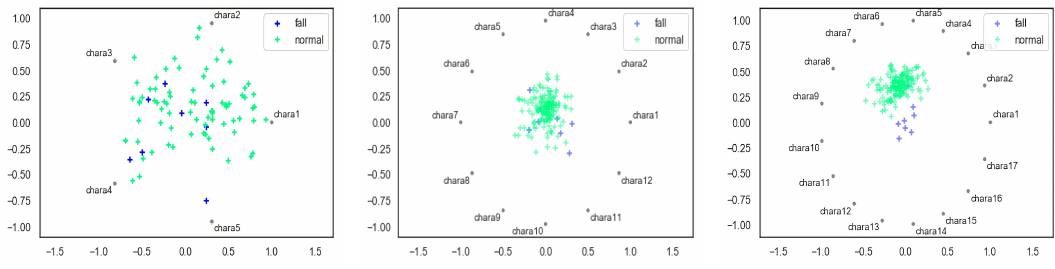
Figure 10. The results of Radviz data